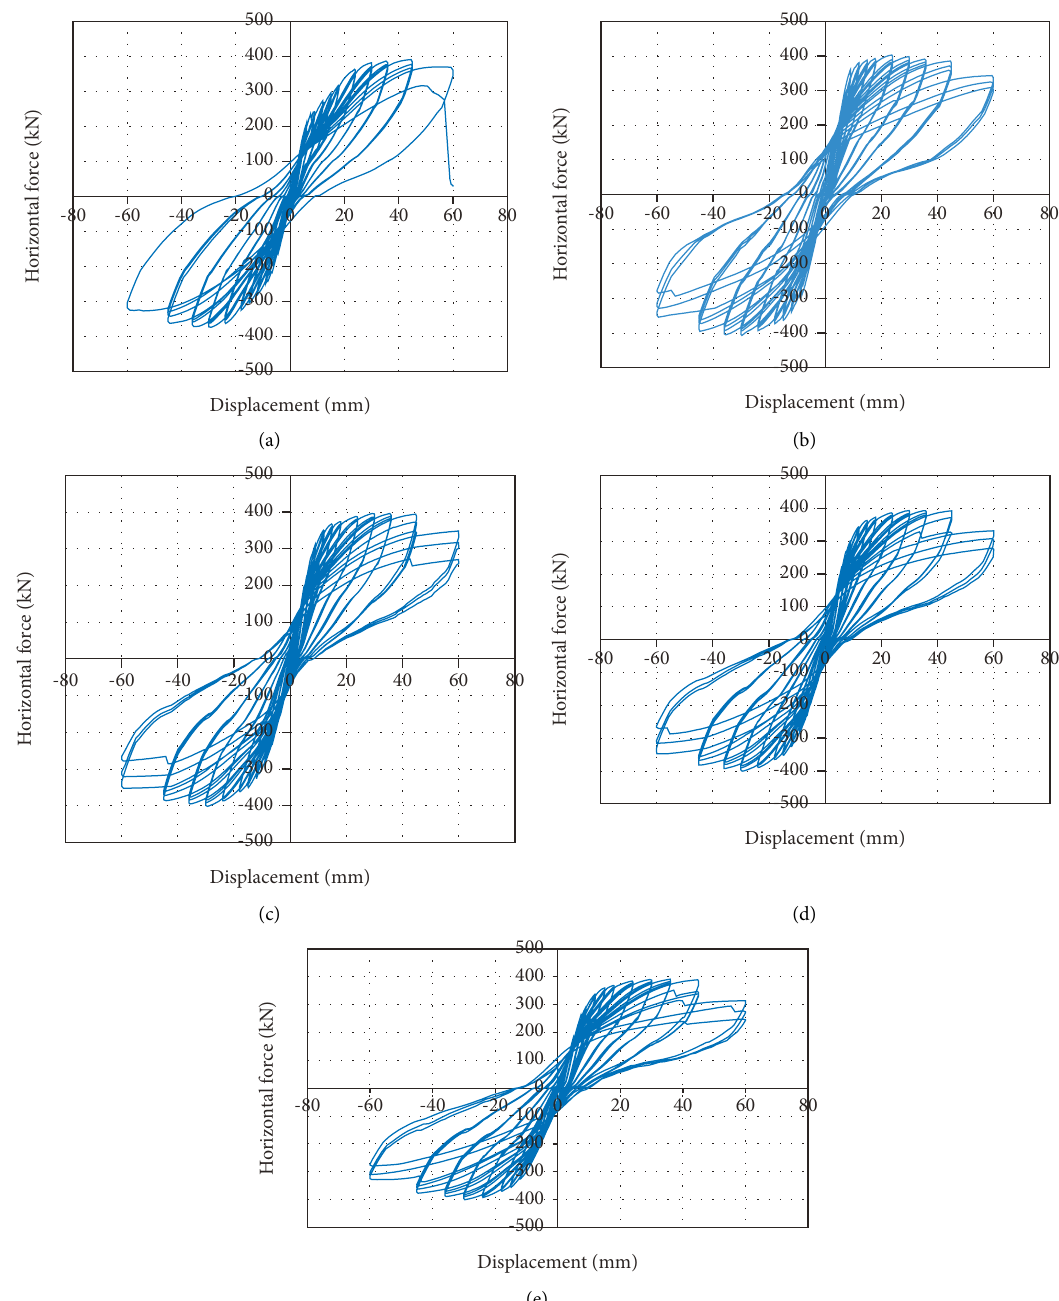
Figure 7: Load-displacement hysteretic curve. (a) XJ. (b) YZ1. (c) YZ2. (d) YZ3. (e)